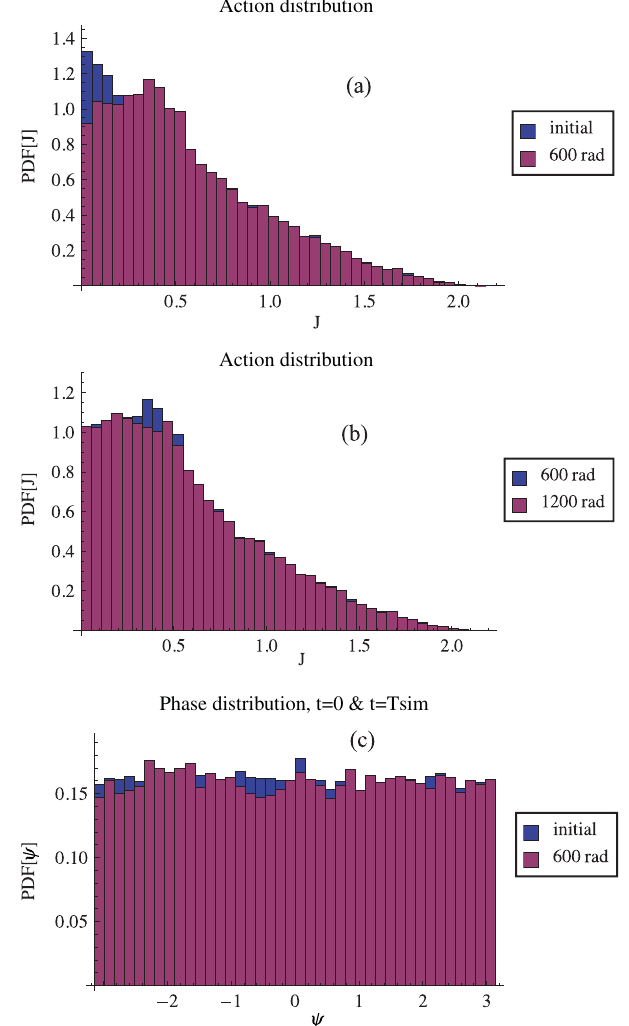
FIG. 1. (a) Distributions over action PDF [J], original (blue) and after the first ramp (pink); the overlapped area is in violet. (b) A similar comparison of the distributions before and after the second ramp. (c) A comparison of the phase distributions PDF [ c ] before and after the first ramp.